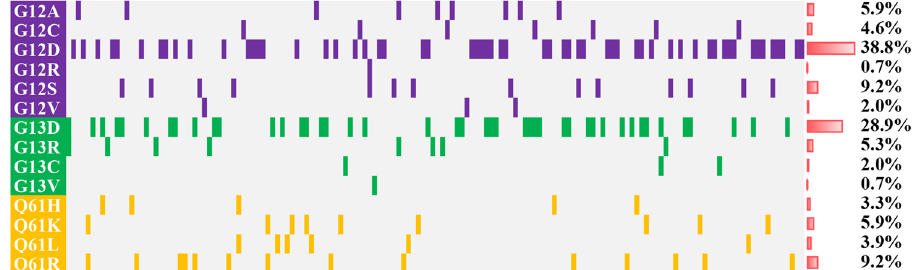
Figure 1. NRAS mutations at codon 12, 13 and 61 of 152 de novo AML patients. Distribution and frequencies are given for NRAS mutations at codon 12, 13 and 61. The boxes in one column represent single patient cases. Mutations were color coded by mutation type. The histogram on the right showed the frequency distribution of all